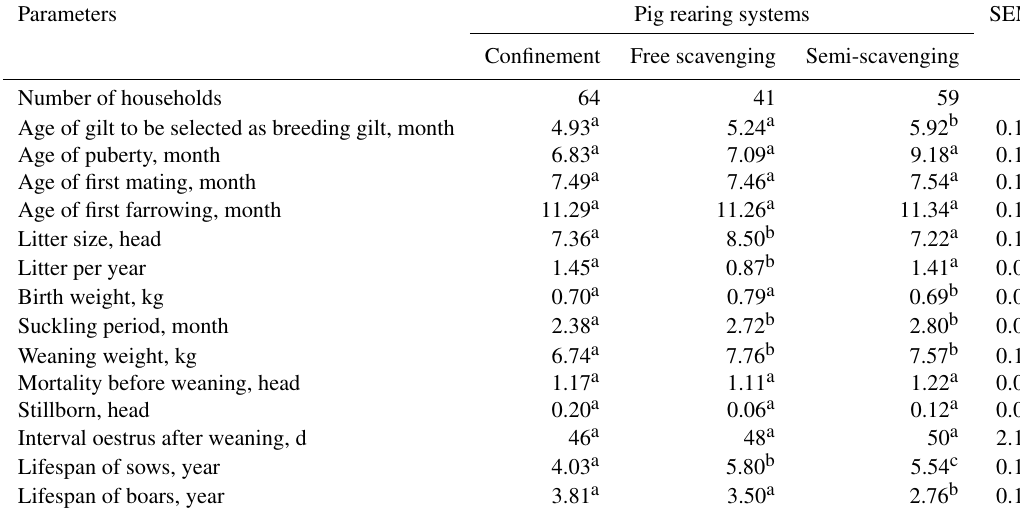
Table 3. Comparison of the reproductive performance of indigenous pigs based on rearing systems. Parameters Pig rearing